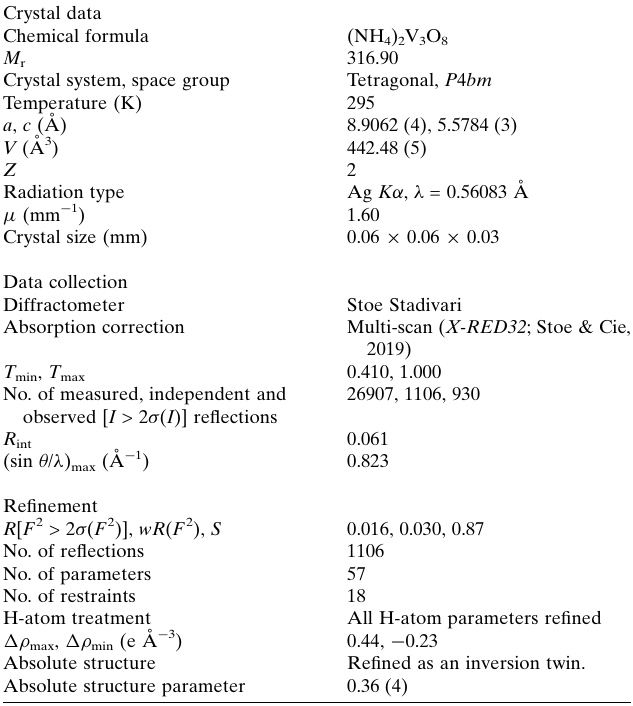
Table 3 Experimental